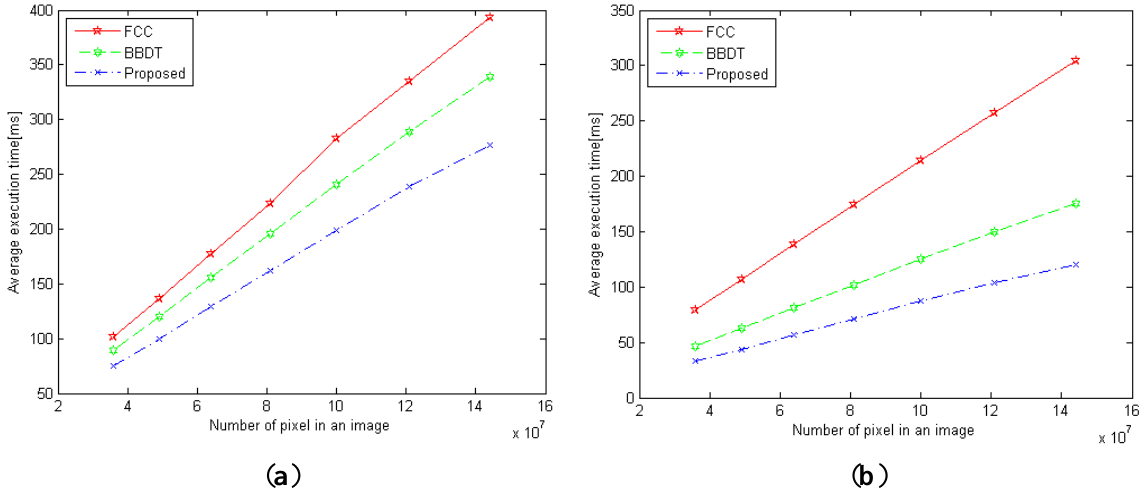
Figure 11. Average execution time for each of the three labeling algorithms versus the scaling image size: ( a ) the entire algorithm, and ( b ) the first-scan